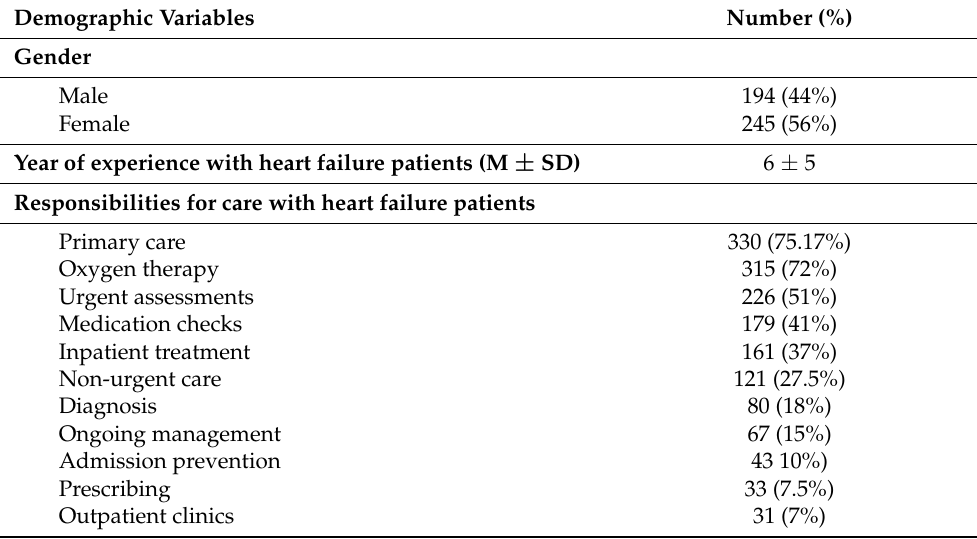
Table 1. Demographic data and nurses’ duties ( n =